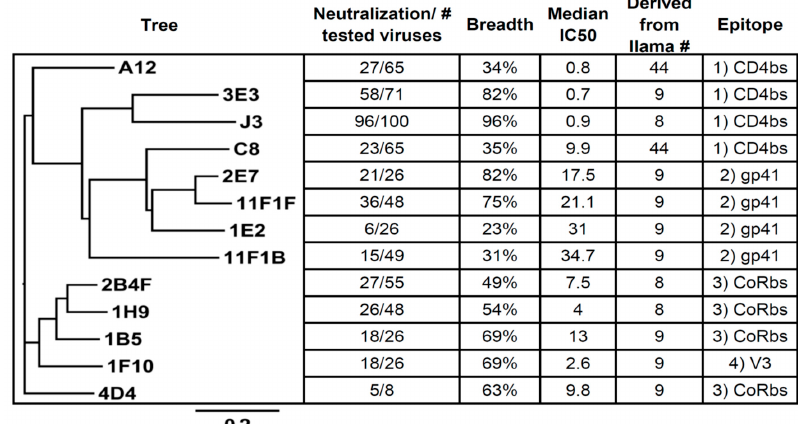
Figure 2. Phylogenetic Tree and Characteristics of the Selected VHH. VHH A12 (and D7) and C8 originate from an immunization with gp120 in llama 44, where the other VHH orginate from immunizations of llamas 8 and 9 with gp140 of UG037 and CN54. The neutralization (breadth), Medium IC50 values, epitopes (this study).